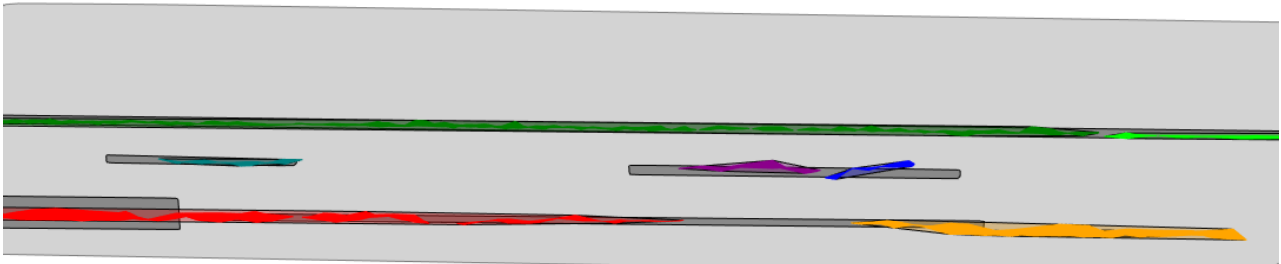
Figure 17. Road spot 3. Crack clusters detected with the proposed algorithm, delimited with both convex hulls ( light color ) and alpha-shapes ( intense color ). Boxes in grey delimit the manually segmented cracked areas.